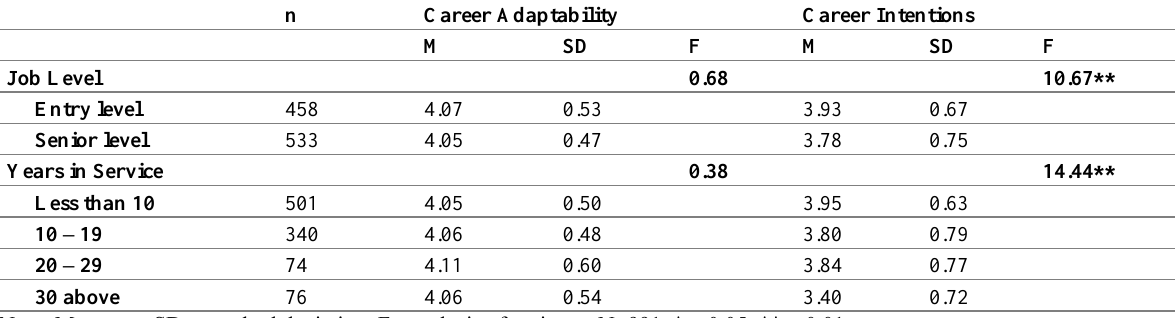
Table 1: Means, standard deviations, and analysis of variance of career adaptability and career intentions according to job level and years in service n Career Adaptability Career Intentions M SD F M